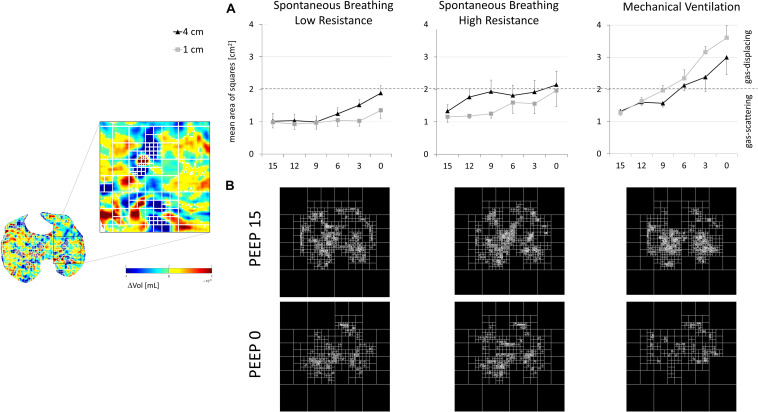
Flow-dependent gas redistribution: quadtree decomposition. Left panel: The quadtree decomposition algorithm applied to delta-volume images (ΔVOL). Right panel: (A) AreaSq equal to 2 cm2 (dashed gray line) was defined as the limit to distinguish between the two patterns of gas redistribution: gas scattering (mean AreaSq < 2 cm2) and gas displacing (mean AreaSq > 2 cm2). Gas scattering mainly characterized spontaneous breathing low resistance (left panel), both at high PEEP levels (vs low PEEP levels) and at 1 cm (vs 4 cm) from the diaphragm. During spontaneous breathing high resistance (central panel), gas scattering became closer to the limit of 2 cm2. Gas displacing mainly characterized low PEEP during controlled mechanical ventilation (right panel). This was true mainly in regions closer to the diaphragm. (B) Quadtree decomposition of a representative animal during the three studied ventilatory modalities. The figure compares PEEP 15 (the highest studied PEEP—upper panel) and PEEP 0 (the lowest studied PEEP—lower panel). The number of iterative divisions of squares was higher for PEEP 15 than for PEEP 0.